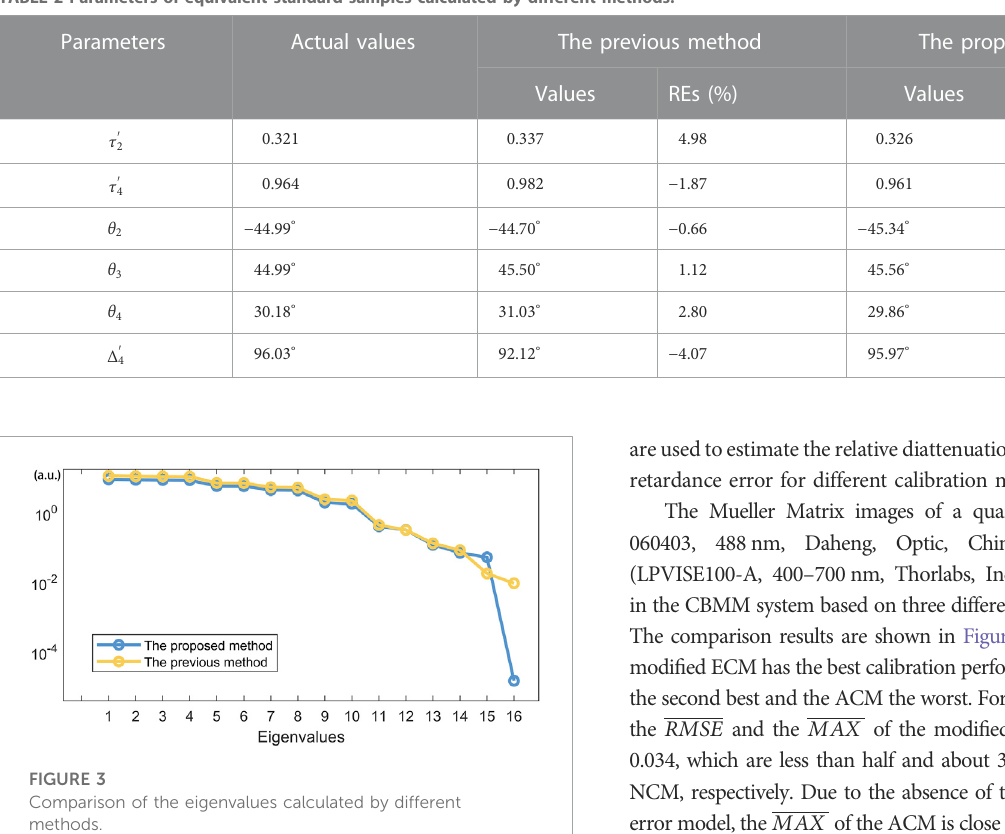
TABLE 2 Parameters of equivalent standard samples calculated by different methods.